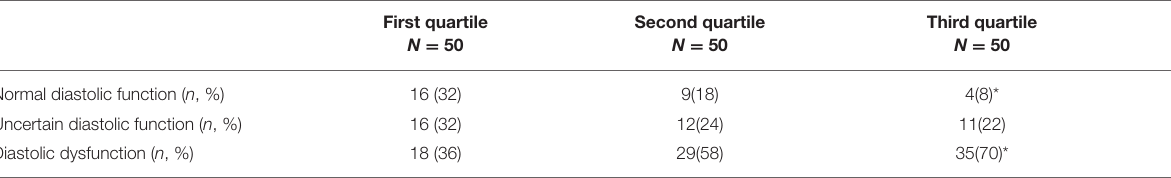
TABLE 3 | Comparison of the left ventricular diastolic function among groups.